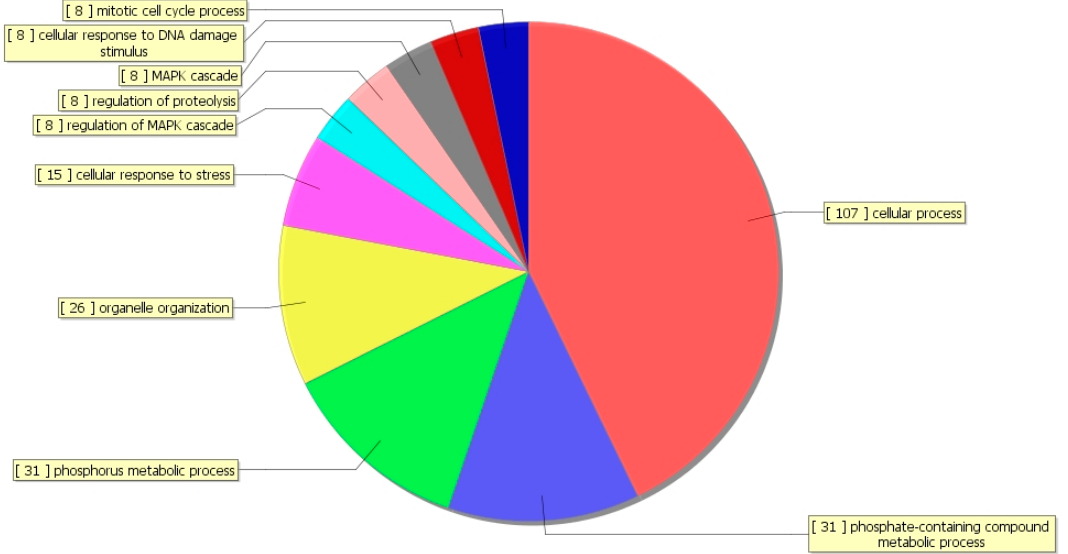
Figure 3. Gene ontology (GO) biological process classification. The pie chart shows the GO biological process (GOBP) sequencing result of genes corresponding to the reduced enrichment peak in the 150 mg/kg (LB) group compared to the control group, with the top ten counts of the significant enrichment terms.